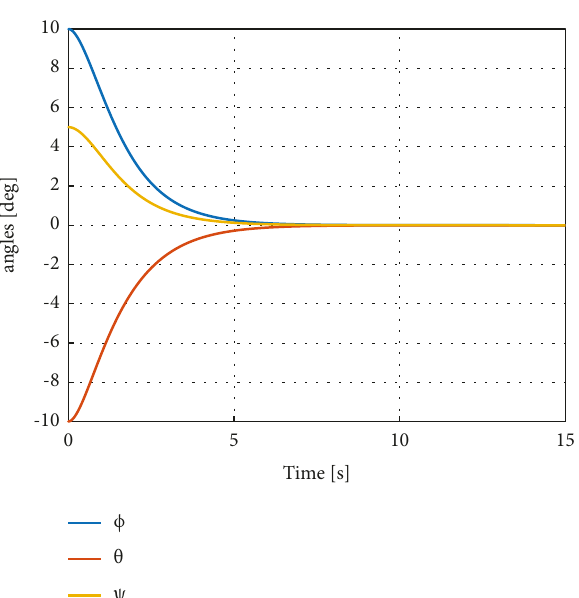
Figure 6: Result of angles ϕ , θ , and ψ as a function of time for implemented PD controller to drive the system states to